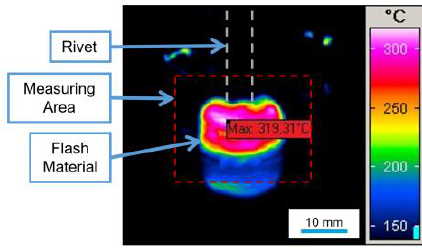
Figure 3. Example of infrared tomography measurements for the expelled flash material.